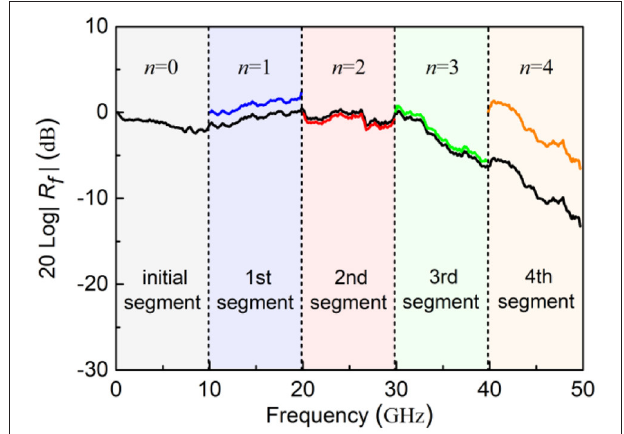
FIGURE 3 | Measured electrical spectra around nf r + 1 f , if r + f 1 ’ + f 2 ’ and ( i + 1) f r – f 1 ’ – f 2 ’ for different segments.